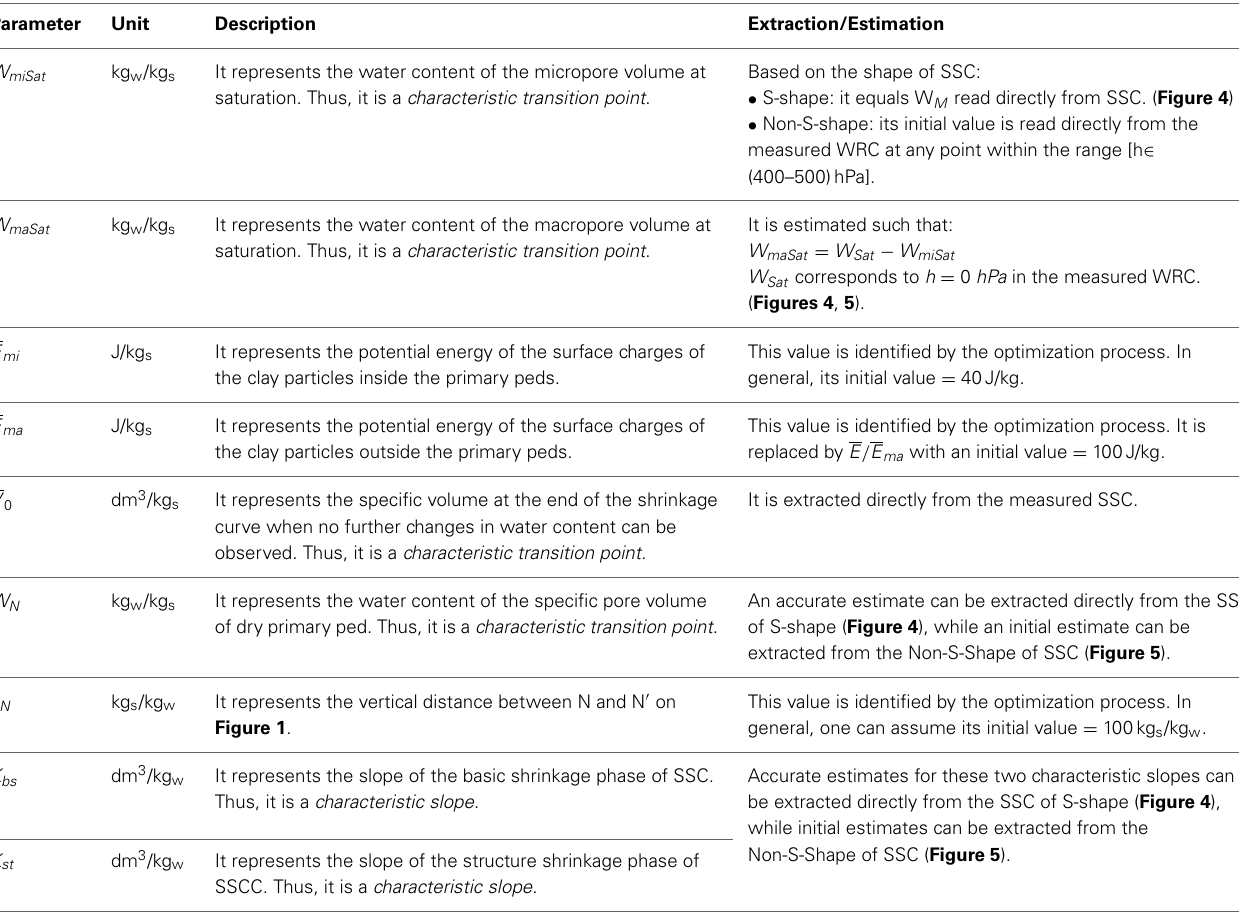
Table 2 | A summary for all the characteristic parameters, included in this study, for both WRC and SSC.